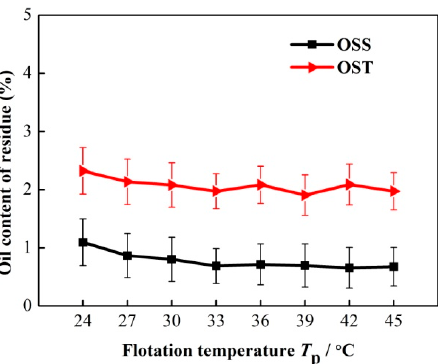
Figure 4. Influence of flotation temperature on the oil content of residue. Flotation conditions: C c = 400 mg/L, T t = 25 min, R s = 1340 r/min, L/OS = 12:1.